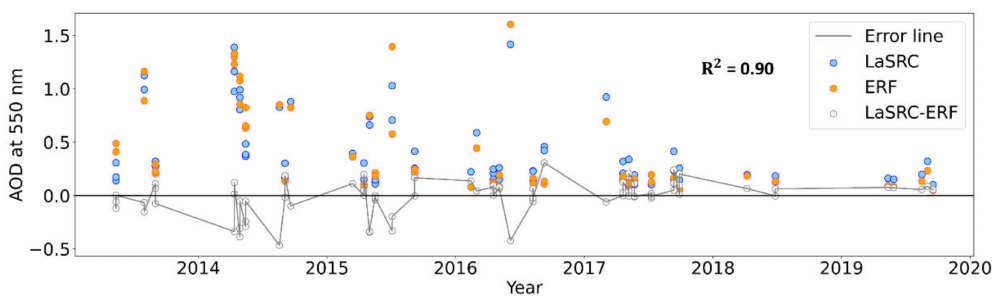
Figure 9. Comparison between the 30 m AOD derived from LaSRC (orange) with the ERF-estimated AOD (blue) in 2013–2019 on the AERONET-site scale (Beijing, Beijing-CAMS, Beijing-RADI, and XiangHe sites). The grey dots represent LaSRC minus ERF AODs. The x-axis represents the time of the points and the y-axis represents the